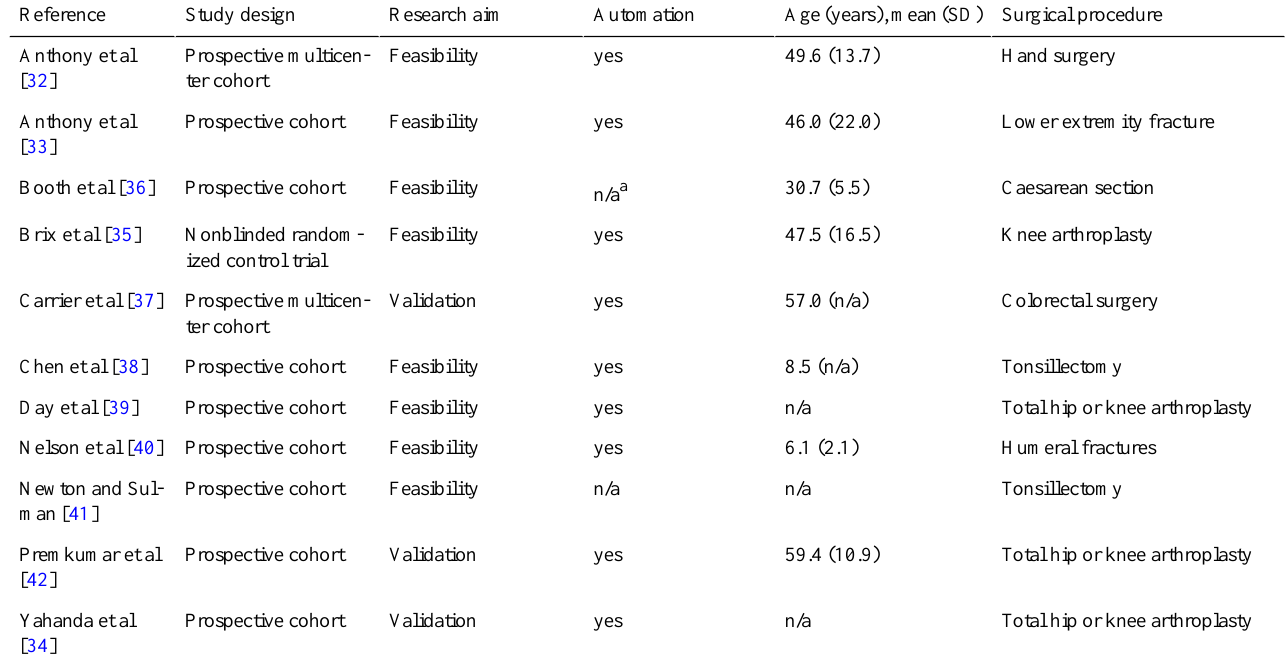
Table 1. Characteristics of the 11